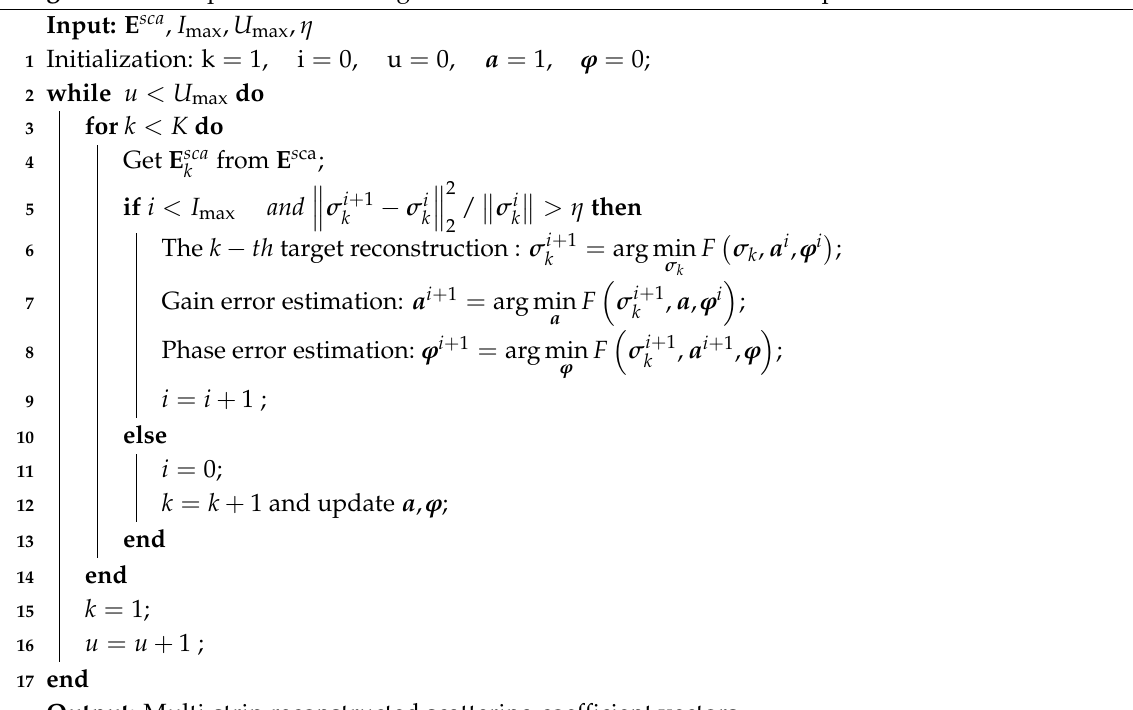
Algorithm 1: Strip-Mode MSCI Algorithm with Self-Calibration of Gain–phase